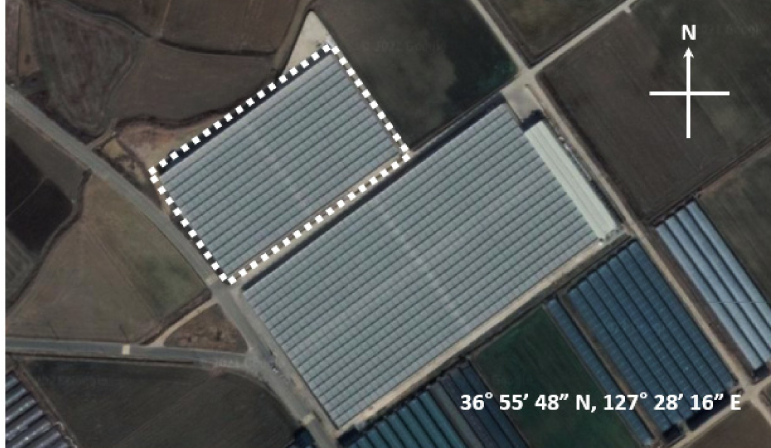
Figure 1. Aerial photograph of the location of the target greenhouse.